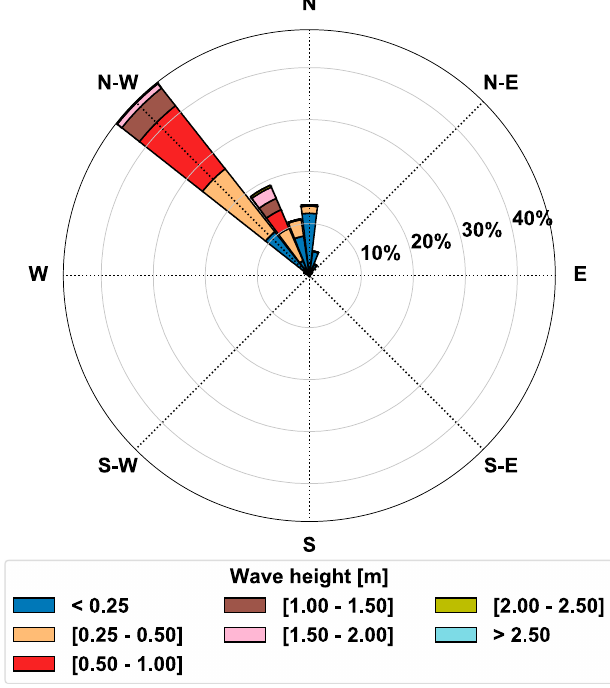
Figure 11. SWAN-computed wave rose at the ADM ins location.